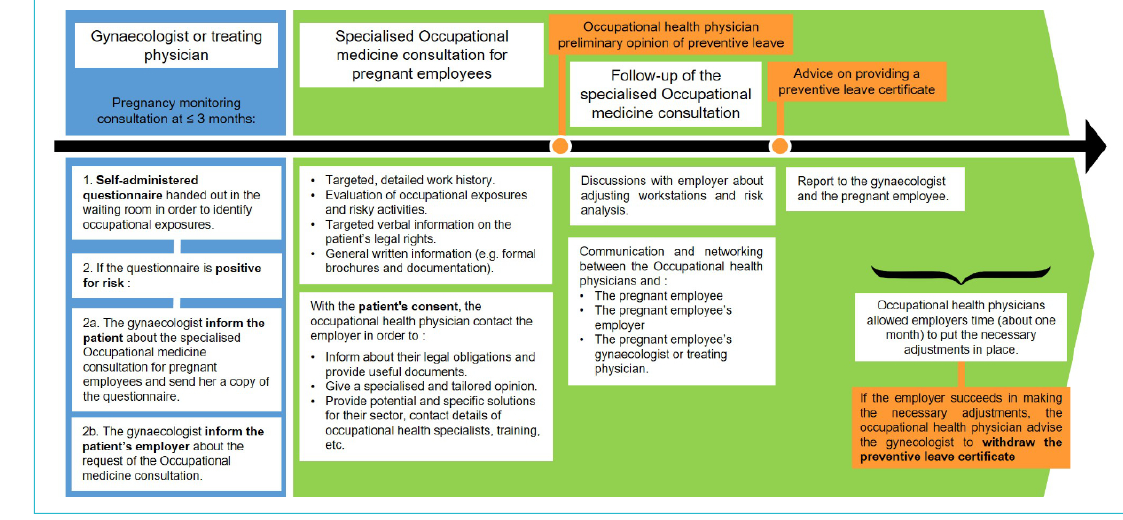
Figure 2: Diagram describing the design of the specialised Occupational Medicine Consultation for pregnant